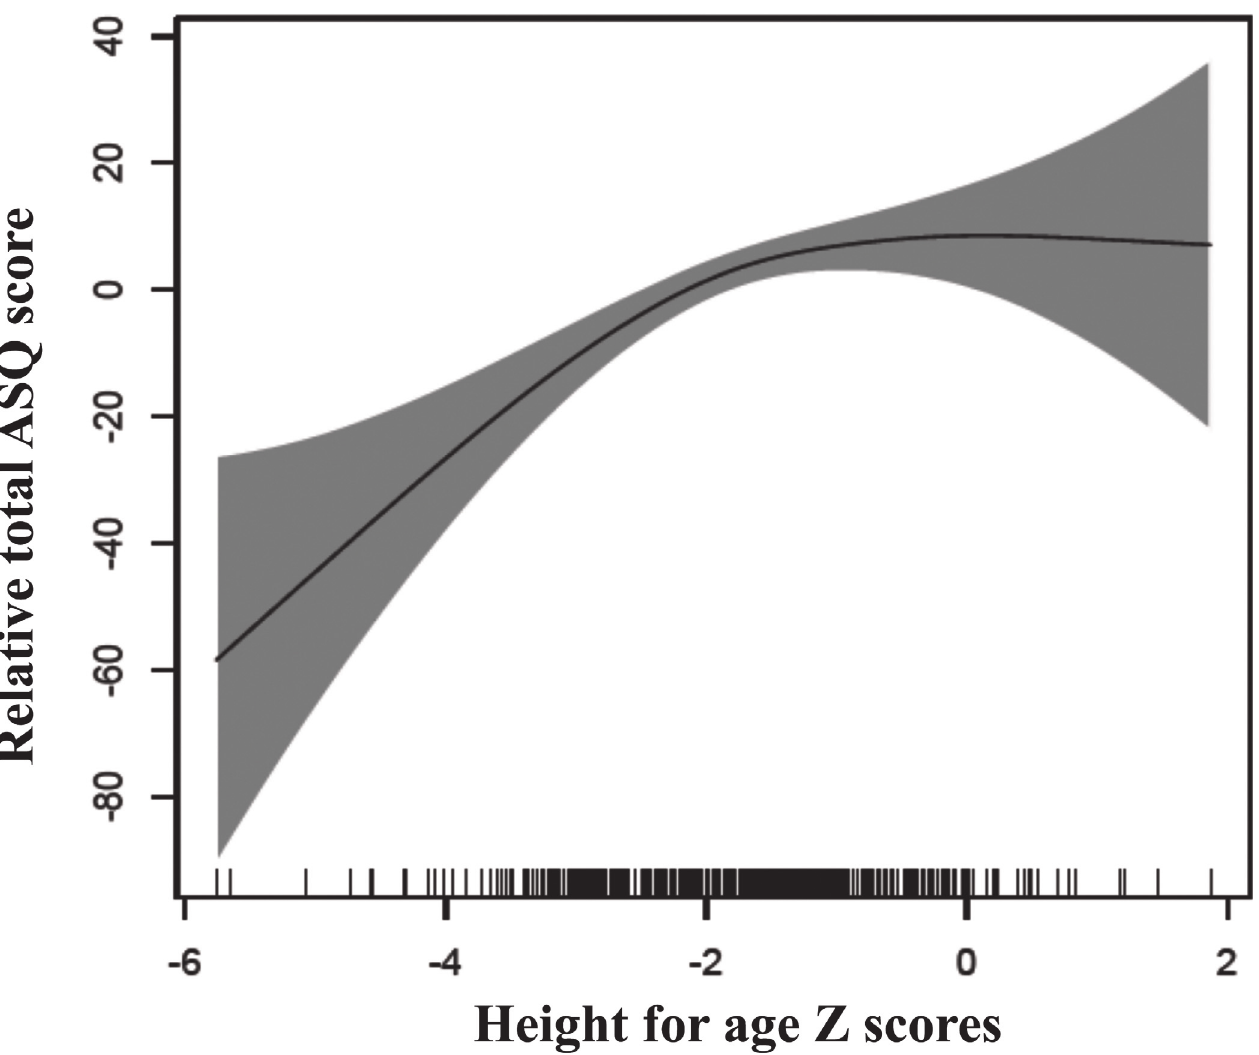
Fig 1. Associations between height for age z-scores and changes in ASQ-scores. The graphs were constructed using generalized additive models in R, the solid line depicts the association of the ASQ-score and HAZ. The Y-axis is centered on the mean total ASQ-score. The shaded area spans the 95% confidence interval of this